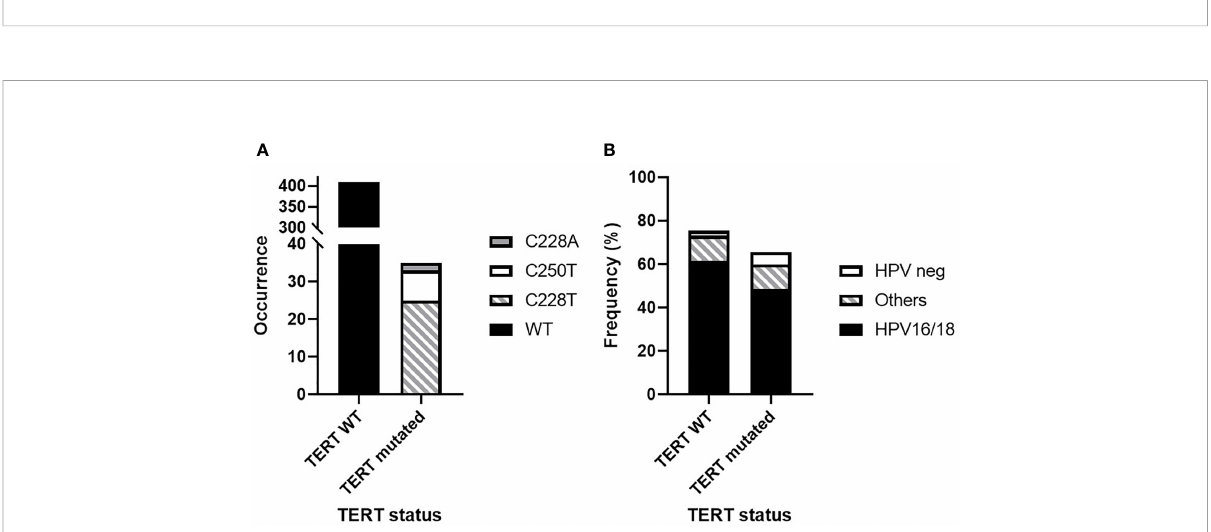
FIGURE 2 TERT promoter mutation distribution in human SCCA from the HPV02 and EDITH V cohorts (444 samples). (A) Wild-type (WT) TERT promoter prevalence versus C228T, C228A and C250T mutations. (B) Distribution of HPV status according to TERT promoter mutations.